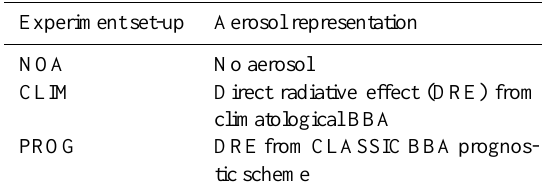
Table 1. Experimental set-ups using the MetUM model. Experiment